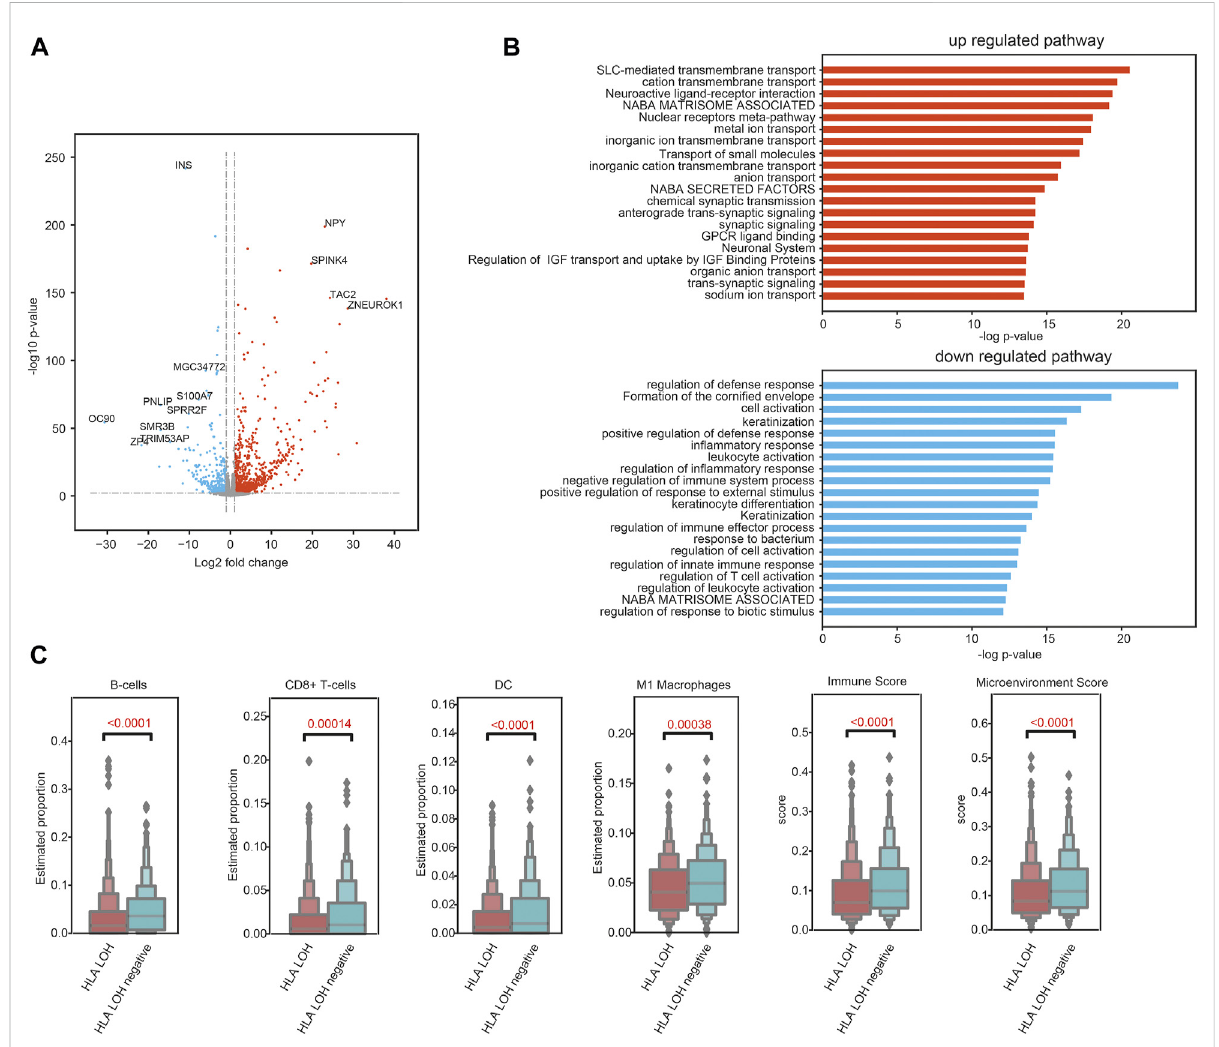
FIGURE 3 Pre-existing immune programs in HLA LOH negative patients . (A) Volcano plot showing DEGs between the statuses of HLA LOH and HLA LOH negative. (B) Functionenrichmentanalysisforgenessigni fi cantlyupregulatedanddownregulatedinHLALOHvs.HLALOHnegative. (C) Comparison of the estimated proportion of lymphocytes between the statuses of HLA LOH and HLA LOH